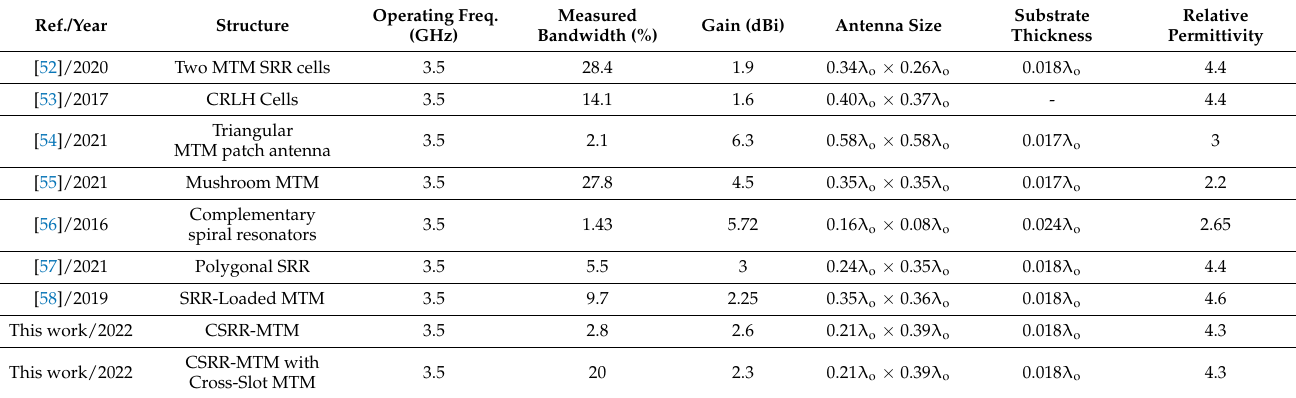
Table 2. Performances comparison of existing MTM antenna with proposed structure at 3.5